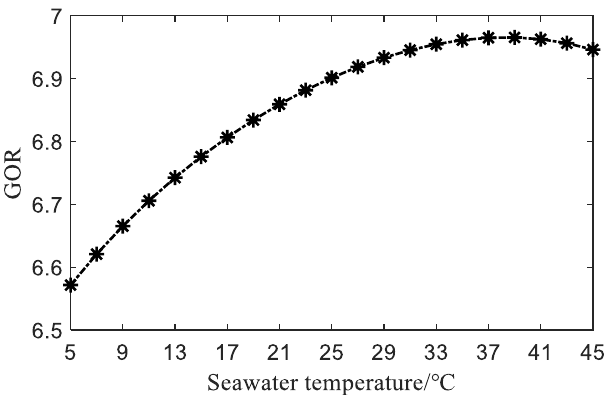
Figure 5. E ff ect of seawater temperature ( T sea ) on gained output ratio Figure 5. Effect of seawater temperature ( sea T ) on gained output ratio (GOR).